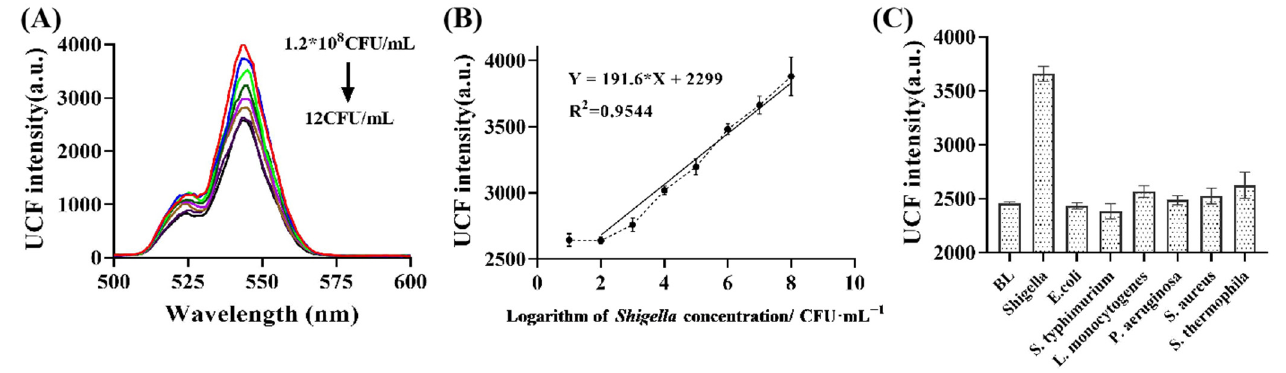
Figure 7. Fluorescence spectra of the nanoprobe at various concentrations of Shigella ( A ); linear relationship between the fluorescence at 550 nm versus Shigella concentration ( B ); selectivity of the developed nanoprobe ( C ). Table 1. Comparison of different sensors for Shigella detection.